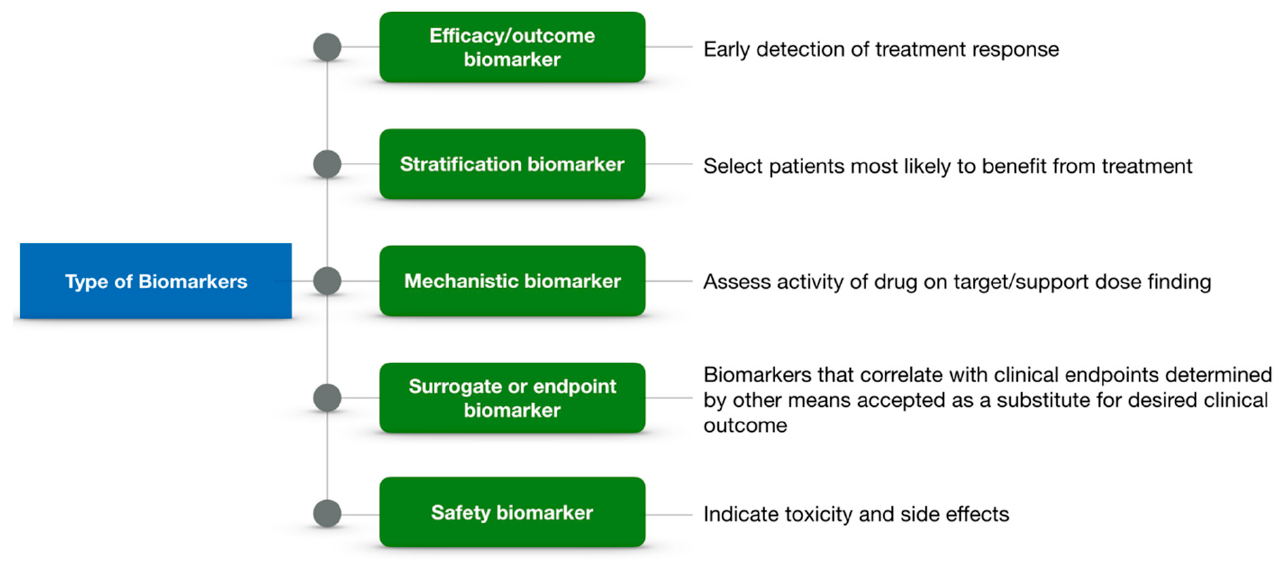
Figure 2. Summary of Biomarker Types and Potential Contexts of Use. The utility range of biomarkers include diagnostic tools (early qualifiers of disease, target recognition), patient identification/triage (e.g., Her-2-Nu positive for treatments with Herceptin ® ), therapeutic response assessment (mechanistic biomarkers and imaging modalities), disease classification and monitoring, and safety indication toxicity and side effects.